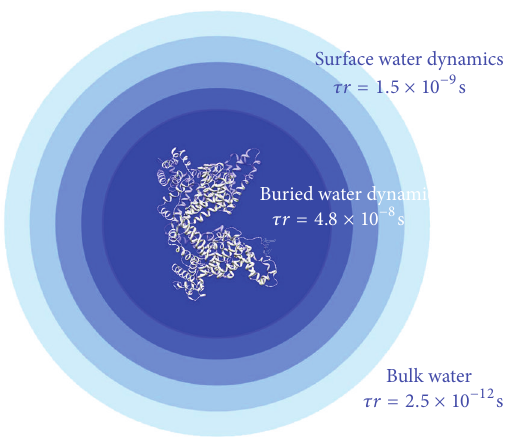
Figure 2: Effect of the ordering effect of proteins on water. Three water environments defined by their dynamical properties can be observed: bulk, surface, and buried water